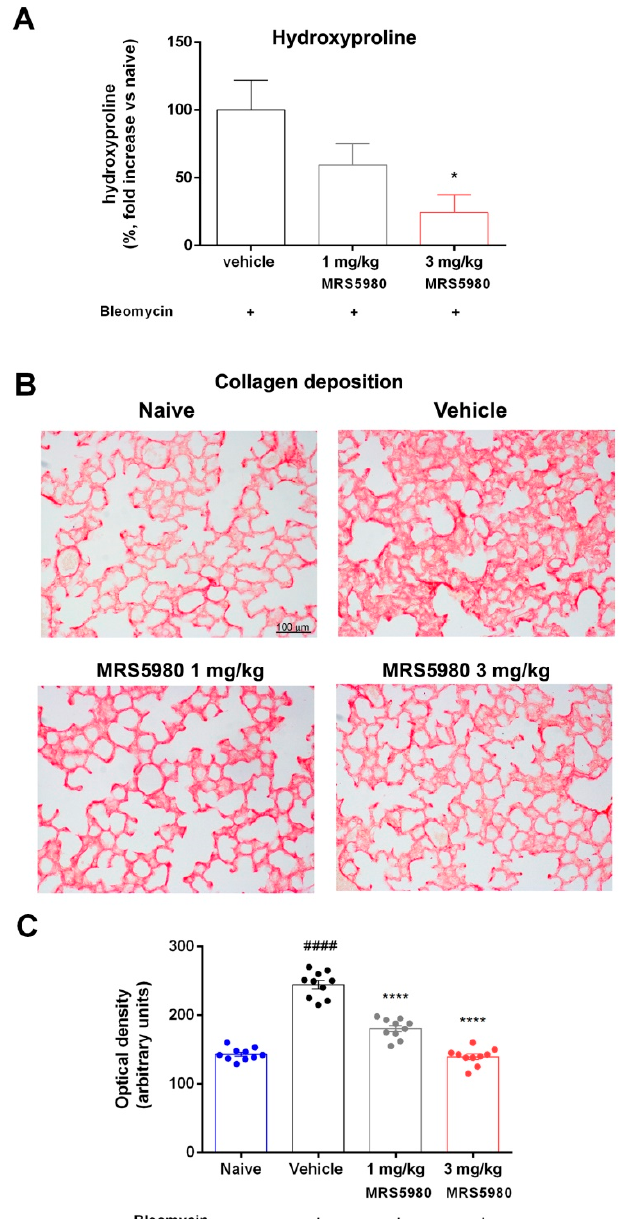
Figure 2. ( A ) Percentage decrease in hydroxyproline content (fold increase versus naïve), in compari- son with vehicle, in lung homogenates. ( B ) Histopathological evaluation of collagen deposition by picrosirius red staining lung analysis (magnification 20 × ). ( C ) In the bar graph is reported a semi- quantitative measure obtained by computer-aided densitometry analysis. Data are mean ± S.E.M for n = 10 mice per group; #### p < 0.0001 vs. naïve; * p < 0.05 and **** p < 0.0001 vs.